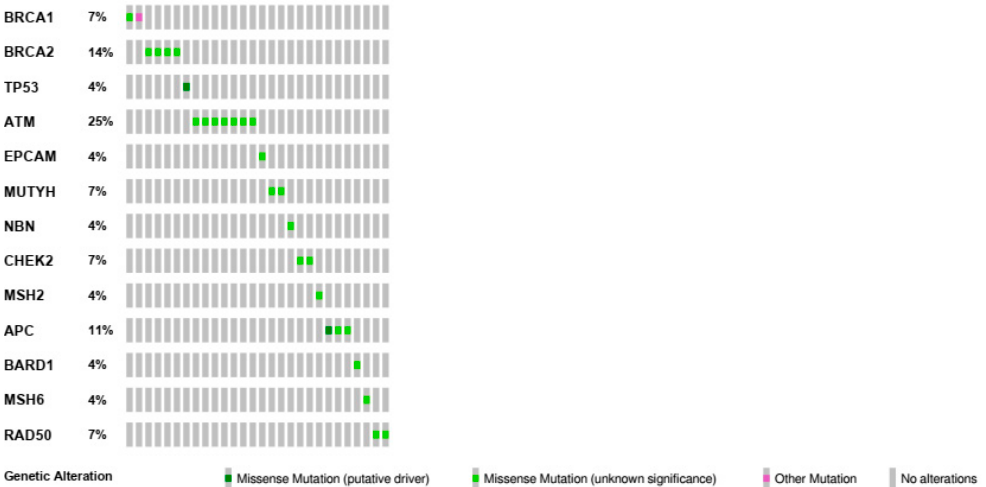
Figure 1. Distribution and frequency of variants of uncertain significance (VUS) identified in different genes of bilateral breast cancer patients. The OncoPrint, showing the identified VUS by heatmap, was obtained by the informatic tool Mutation Mapper-cBioPortal for Cancer Genomics.